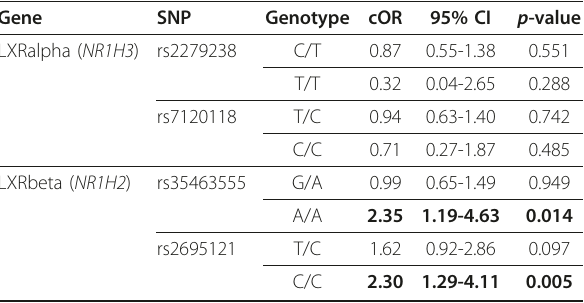
Table 5 Logistic regression analysis of the associations between LXRalpha or LXRbeta SNPs and preeclampsia (univariate analysis)